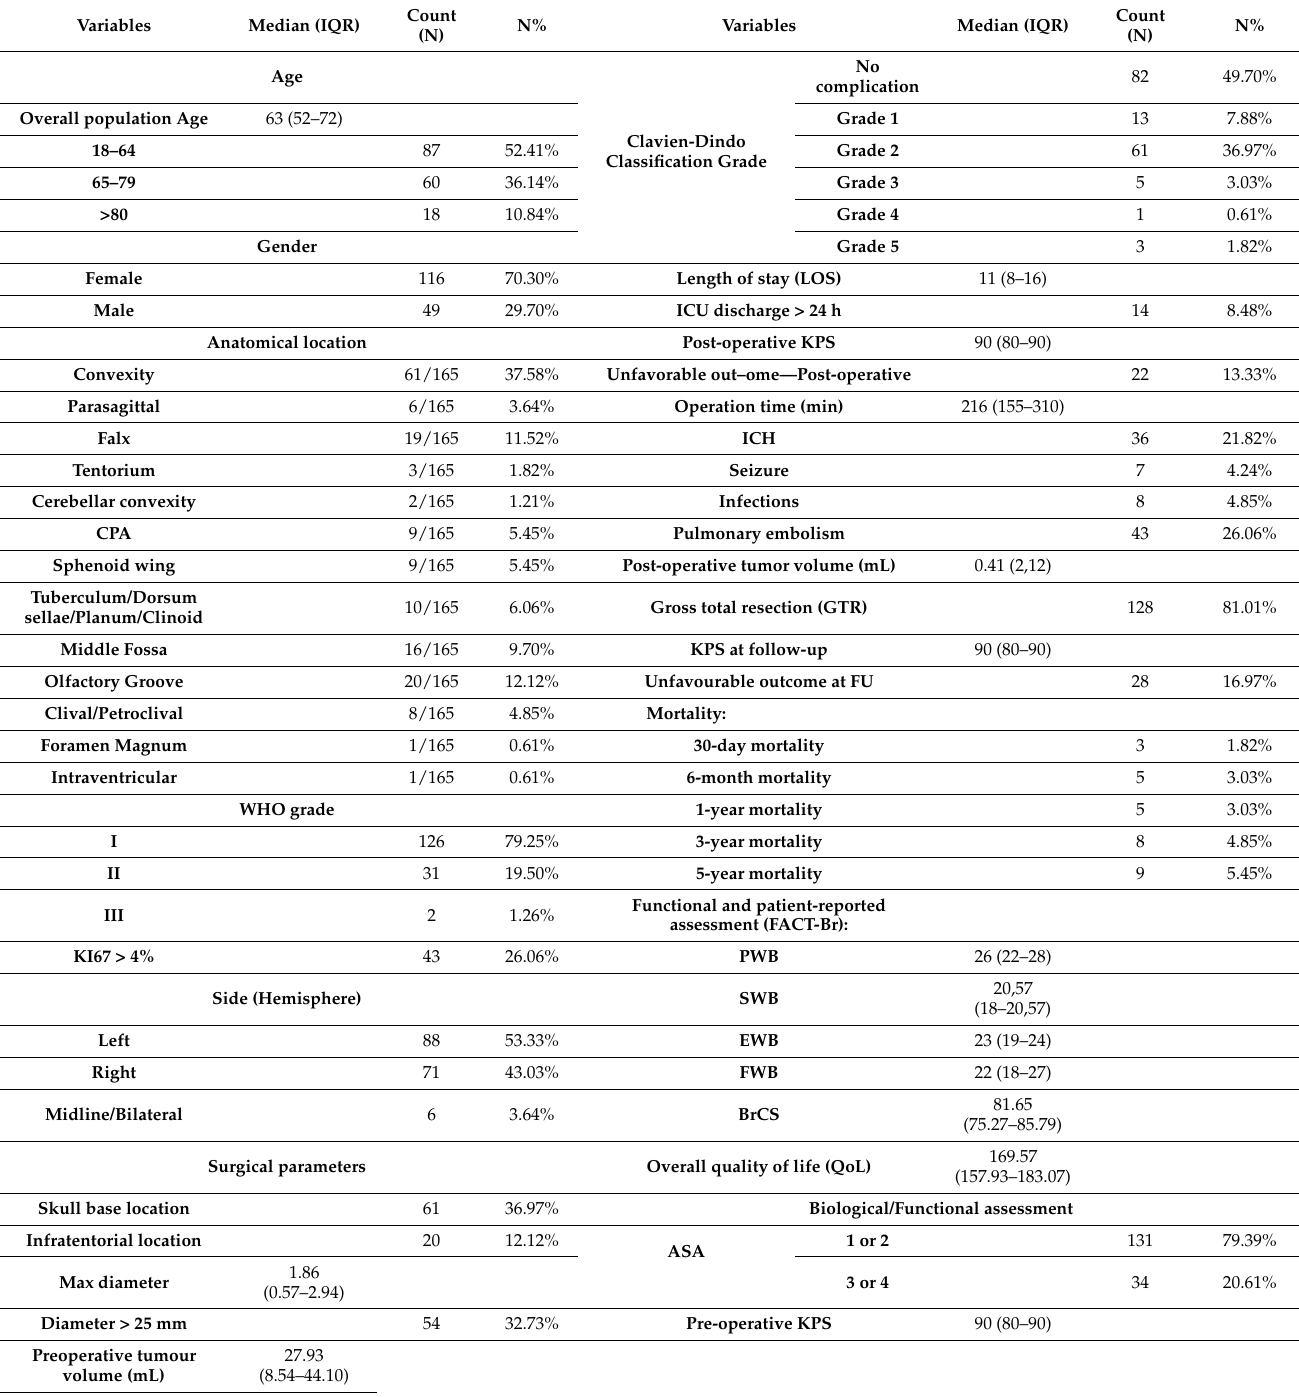
Table 2. Demographic characteristics and complications (N = 165